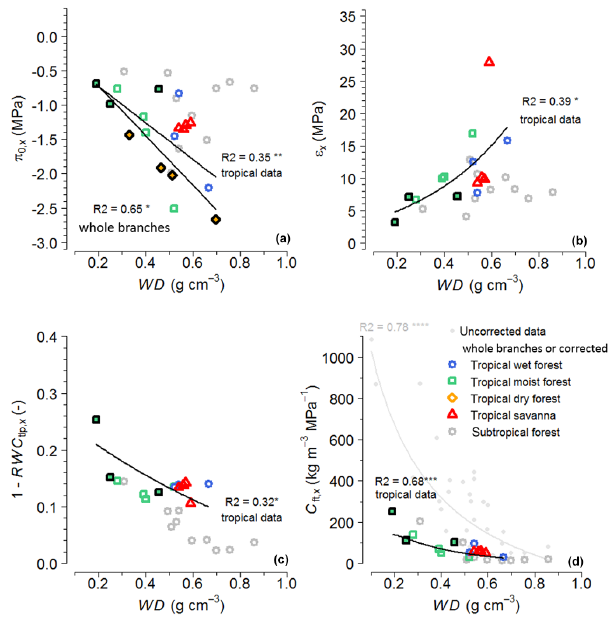
Figure 3. Tropical synthesis of sapwood PV parameters and resul- tant capacitance in relation to wood density (WD). (a) Osmotic po- tential at full turgor ( π o , x ) , (b) bulk elastic modulus ( ε x ) , (c) rela- tive water deficit at turgor loss ( R tlp,x = 1 − RWC tlp,x ) , and (d) ca- pacitance at full turgor ( C ft,x ) . Sapwood PV curves conducted on trunk cores, and their associated parameters and capacitance are bias-corrected (see main text). Original data are shown in light gray in panel (d) and Supplement Fig. S2.1. Color scheme is given in the legend of panel (d) . Asterisk codes for significance are the same as in Fig.